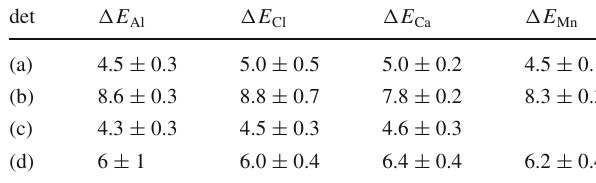
Table 2 Energy resolution FWHM expressed in eV obtained with the four designs reported in Fig. 2. For the Manganese the line considered is the K α ; in the case of detector (c) it was not possible to estimate the energy resolution relative to this line because at this energy the slew rate required exceeded the available one which is limited at 0.5 φ